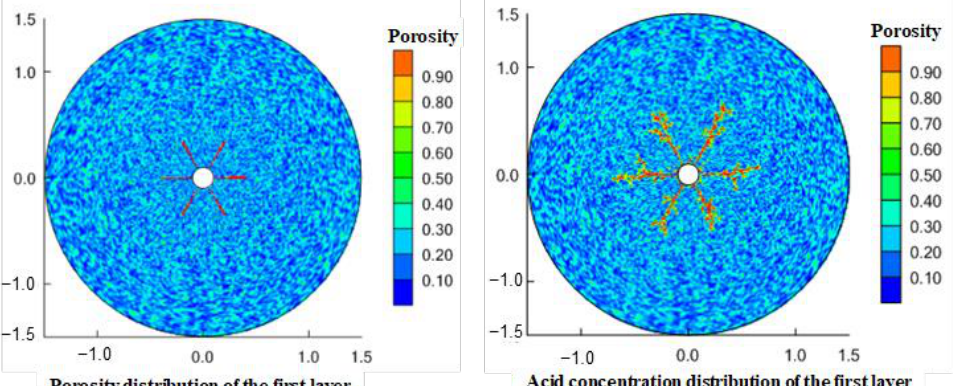
Figure 13. Effect of pore space distribution on the expansion of gelling acid wormhole.